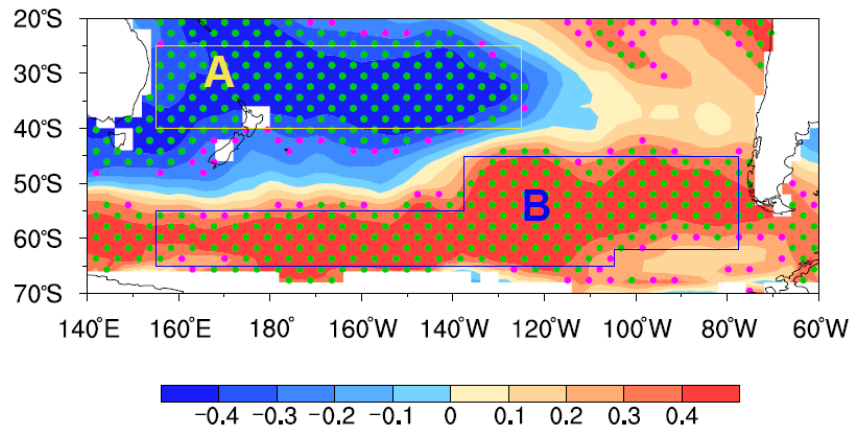
Figure 3. Partial correlation map between the winter NAMPI and autumn sea surface temperature anomalies (SSTAs)s without the El Niño–Southern Oscillation (ENSO) signal. The magenta and green stippled areas indicate statistical significance at the 90% and 95% confidence levels, respectively.